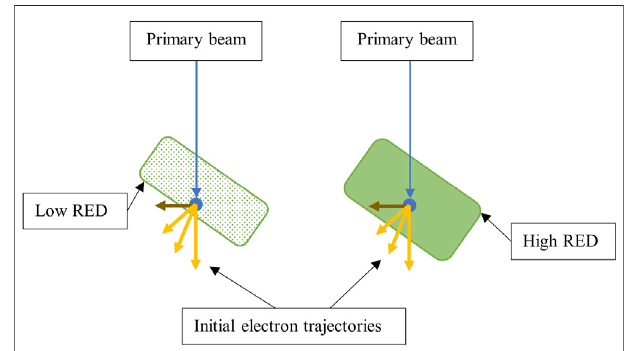
FIGURE 12| Diagram showing how increasing the coil RED can change resulting ESE doses. One can observe that higher RED materials have increased water equivalent thickness. Hence, laterally scattered electrons (brown) are not energetic enough to escape. Note that the effect of the magnetic fi eld on electron paths and the full electron distribution are not